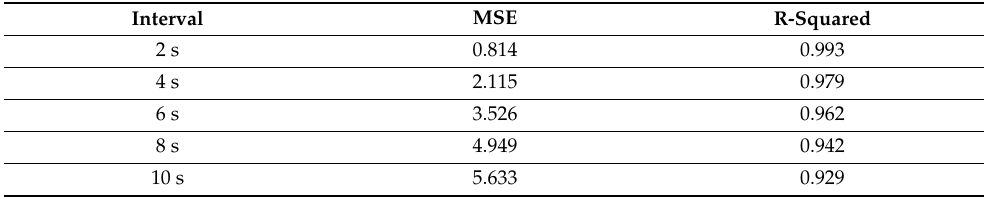
Table 9. RSRP prediction test results using CNN.